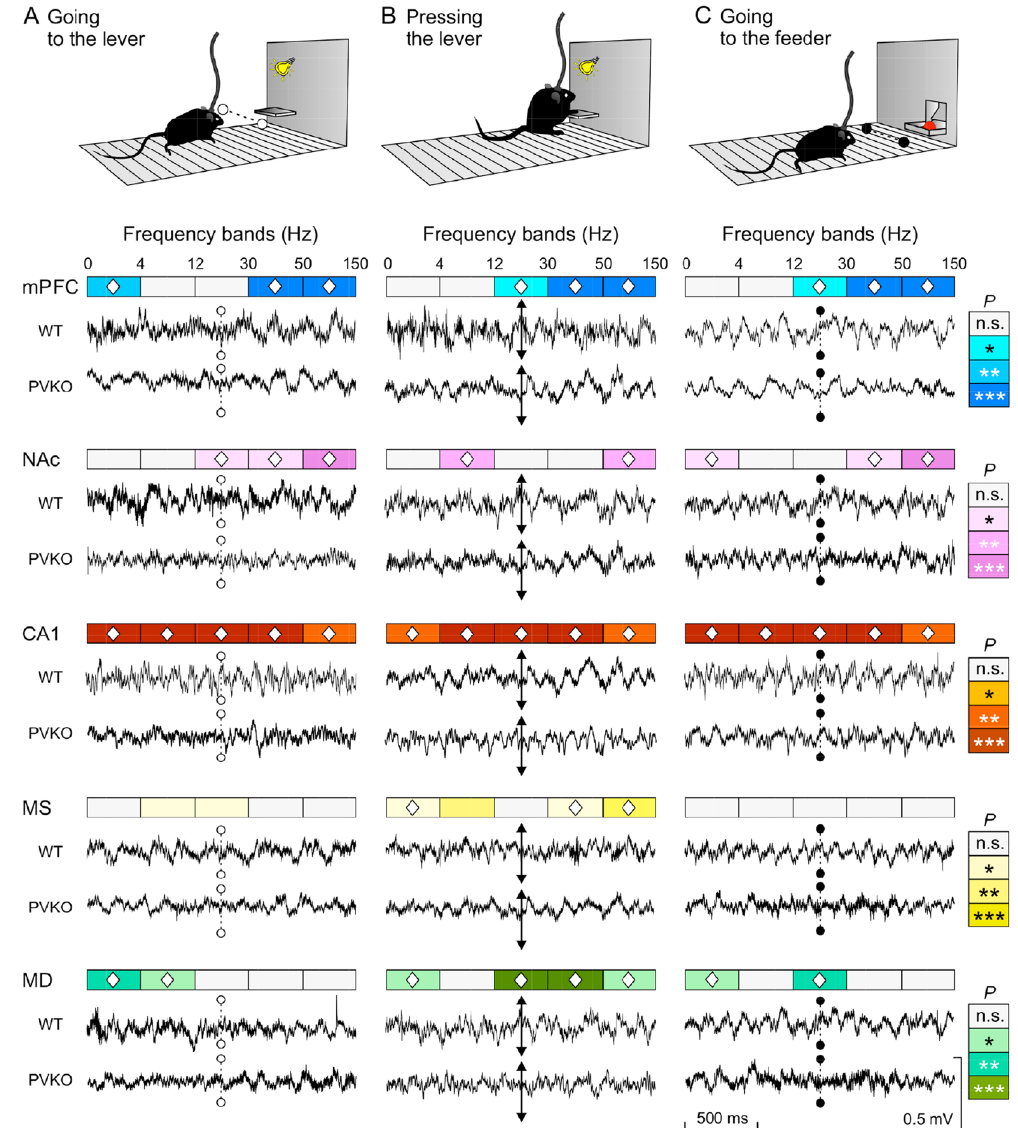
Figure 2. Differences in LFPs recorded at the five selected brain areas in WT and PVKO mice during the performance of the light/dark operant conditioning test. ( A ) Representative LFPs recorded at the indicated sites (mPFC in blue; NAc in magenta; CA1 in brown; MS in yellow; and MD in cyan) from WT and PVKO mice. Illustrated records were collected from one second before to one second after crossing (dotted line) the light beam when approaching the lever. ( B ) Representative LFPs collected when mice pressed the lever (double arrowed line). C Representative LFPs collected when crossing the light beam to reach the feeder (dotted line). Calibrations in ( C ) are same for ( A ) and ( B ). Significant differences for the indicated frequency bands ( δ : 1–4 Hz; θ : 4–12 Hz; β : 12–30 Hz; low − γ : 30–50 Hz; and high − γ : 50–150 Hz) were calculated from 16 similar LFP segments collected from n = 4 mice. Note the significant differences (* P < 0.05 ; ** P < 0.01 ; *** P < 0.001 ; significances are indicated in color intensity for each selected brain site) between LFP spectral powers obtained from the two groups of mice during these appetitive ( A , B ) and consummatory ( C ) behaviors. The symbol ♦ indicates the frequency bands in which the LFP spectral powers from PVKO mice were significantly decreased with respect to those from WT mice (for details see Supplementary Table